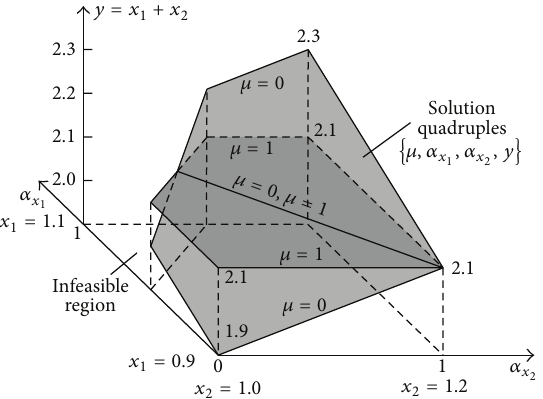
Figure 14: Projection of the full 4D result granule of the addition of two fuzzy numbers “about 1.0” and “about 1.1” with taking into account the order relation 𝑥 2 > 𝑥 1 onto the 3D space 𝑋 1 × 𝑋 2 × 𝜇